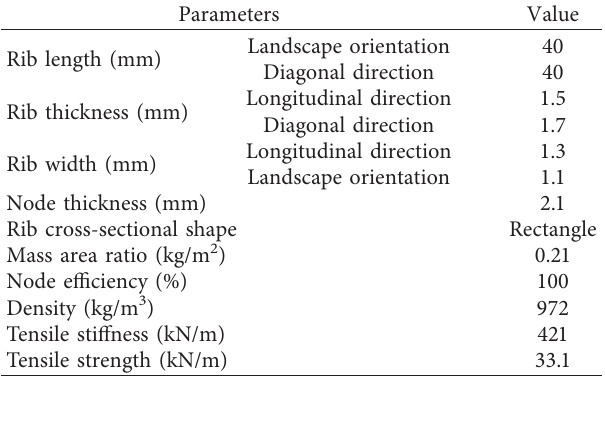
Table 2: Physical performance indexes of the triaxial geogrid.